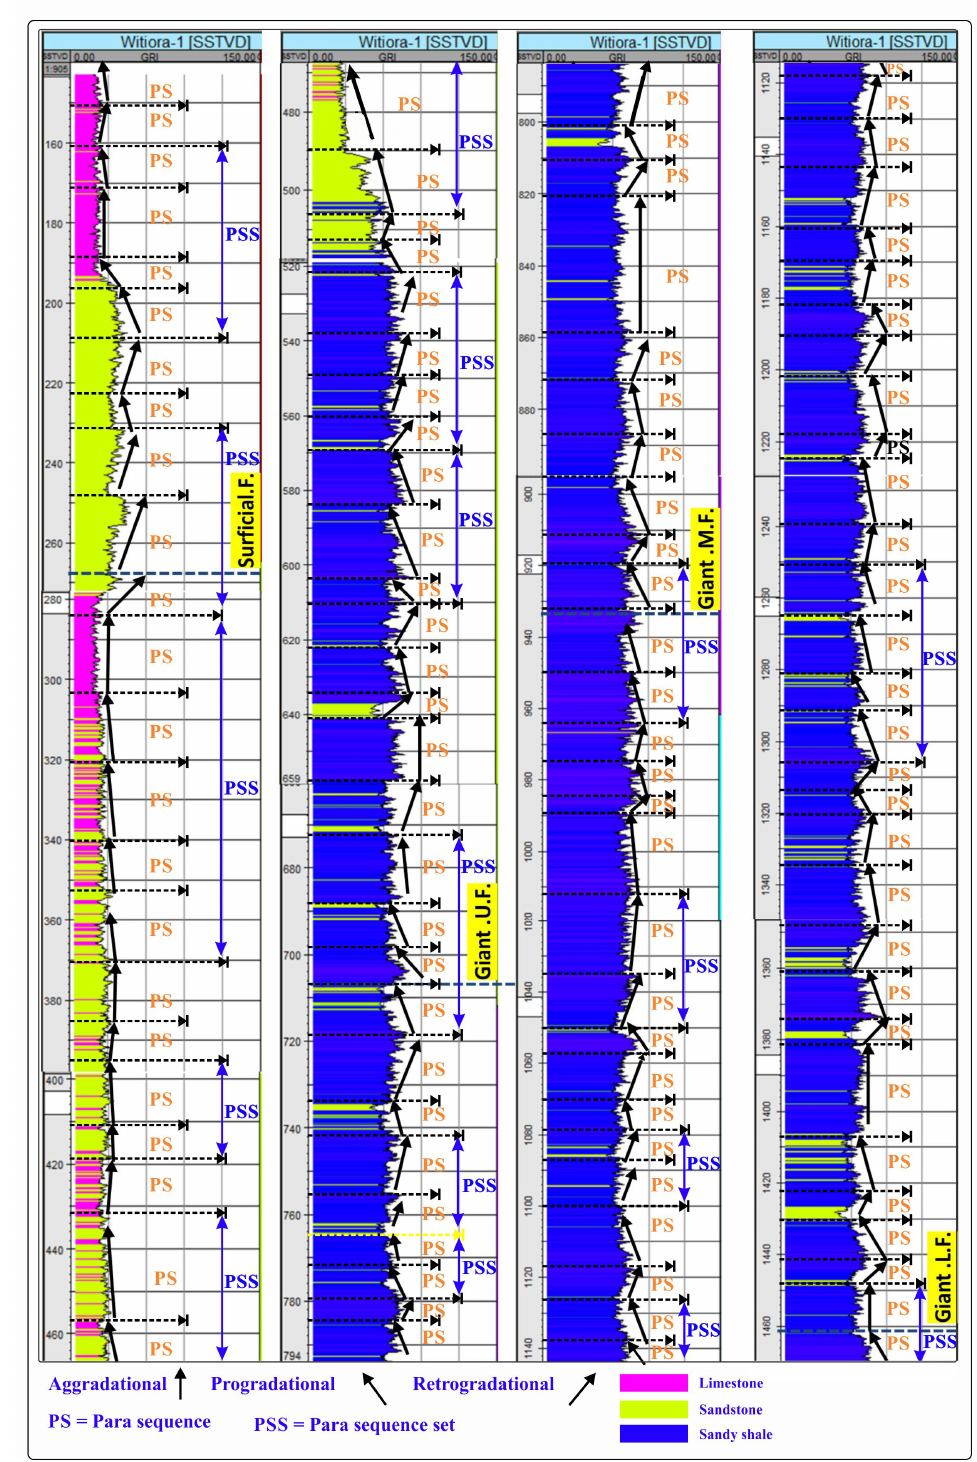
Figure 9. The parasequence system tracts from Surficial Formation to Lower Giant